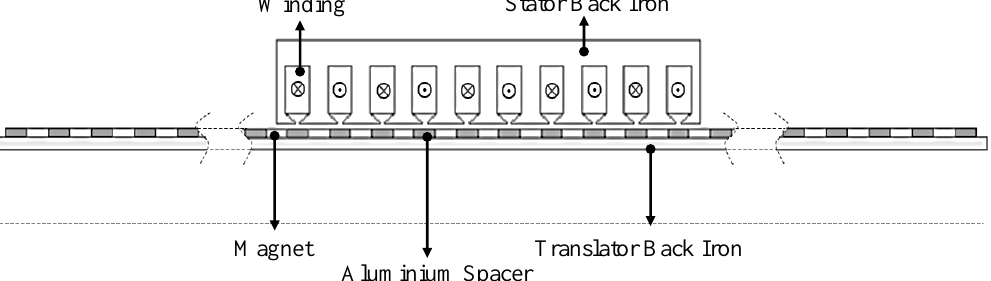
Figure 4. 2-Dimension Quarter Symmetry Cross-Section of TPMLM-S. Table 3. Dimensions of the Proposed Design.